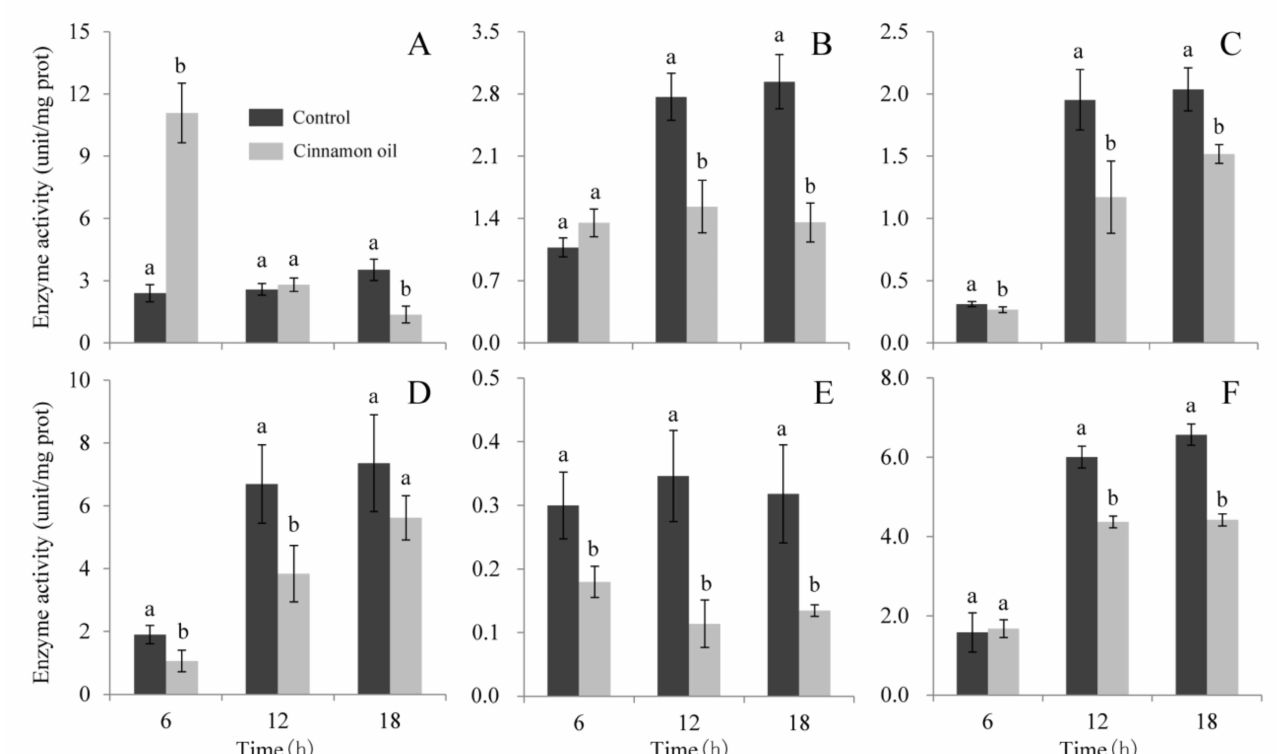
Figure 6. Effects of 0.25 mg L − 1 cinnamon oil on β -glucosidase ( A ), α -ketoglutarate dehydrogenase ( B ), hexokinase ( C ), pyruvate kinase ( D ), 6-phosphofructokinase ( E ), and glucose 6-phosphate dehydrogenase ( F ) activities in P. expansum. One unit of β -glucosidase activity was defined as the amount of enzyme capable of producing 1 nmoL p-nitrophenol per milligram of protein in one hour. One unit of α -ketoglutarate dehydrogenase activity was defined as the amount of enzyme capable of producing 1 nmoL NADH (nicotinamide adenine dinucleotide) per min per milligram of protein. One unit of hexokinase activity was defined as the amount of enzyme capable of producing 1 nmoL NADPH (nicotinamide adenine dinucleotide phosphate) per min per milligram of protein. One unit of pyruvate kinase activity was defined as the amount of enzyme capable of consuming 1 nmoL NADH (nicotinamide adenine dinucleotide) per min per milligram of protein. One unit of 6-phosphofructokinase was defined as the amount of enzyme capable of converting 1 nmoL fructose-6-phosphate and 1 nmoL ATP to 1 nmoL fructose-1, 6-diphosphate and 1 ADP per min per milligram of protein. One unit of 6-phosphatedehydrogenase activity was defined as the amount of enzyme capable of producing 1 nmoL NADPH (nicotinamide adenine dinucleotide phosphate) per min per milligram of protein. Bar represents the standard deviation of the means of three independent experiments. Lower-case letters indicate significant differences at p < 0.05 at each time